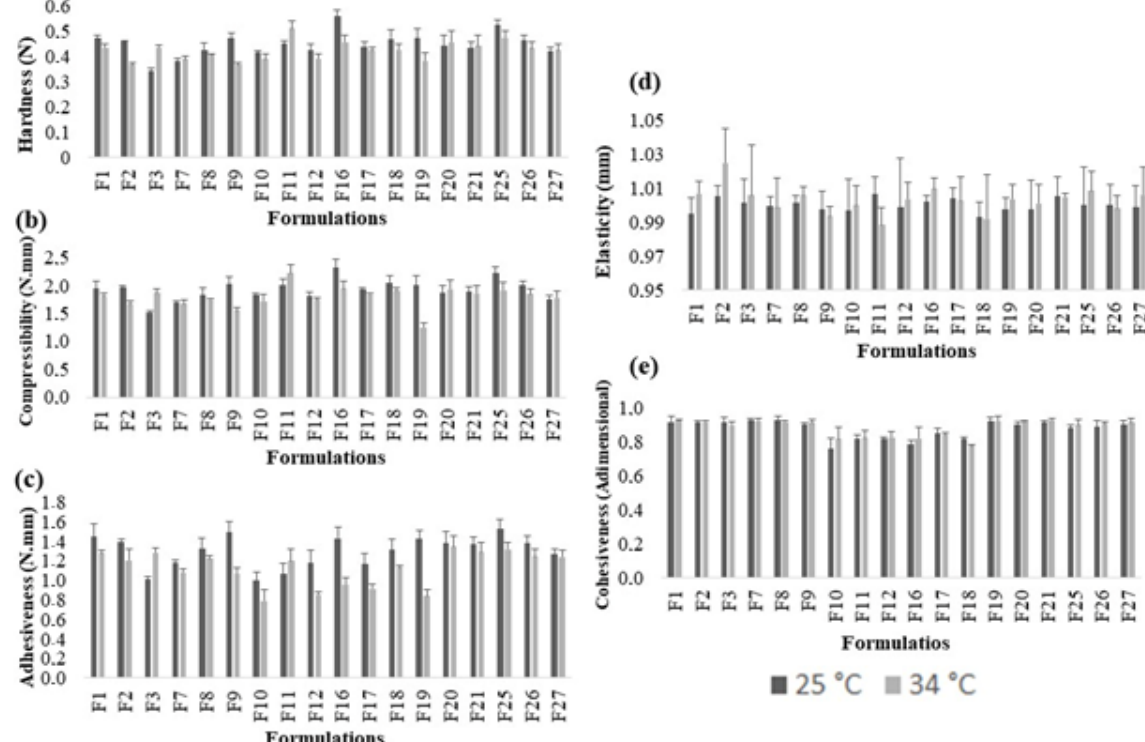
Figure 4. The effect of temperature, polymer type, vegetable oil type, and bioactive agent composition on TPA properties of the emulgels at 25 ◦ C and 34 ◦ C: ( a ) hardness; ( b ) compressibility; ( c ) adhesiveness; ( d ) elasticity; ( e ) cohesiveness. Each bar graph represents the average, and the relative standard deviation was less than 10% (n = 3).